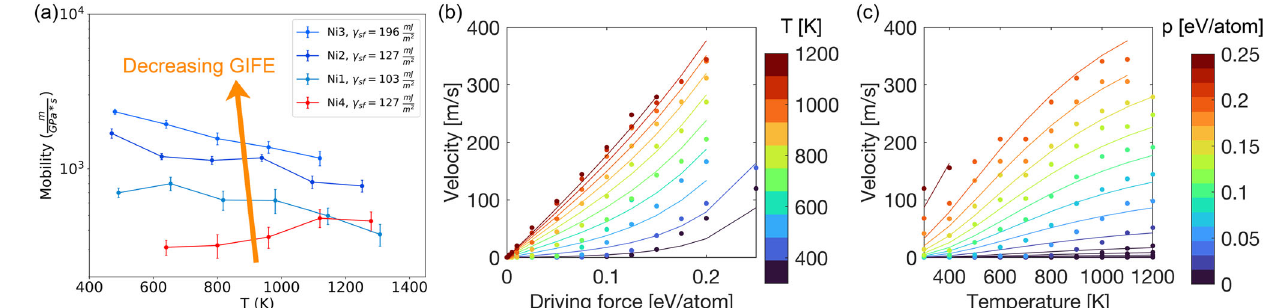
Fig. 3 Observations reconciled with classical model. a Mobility vs. temperature plot for 4 Ni interatomic potentials, reproduced with permission and adapted from ref. 13 . Plots of velocity vs. b driving force and c temperature, for data reproduced from ref. 38 as individual datapoints along with a single fi t over all conditions to Eq. (3) plotted as